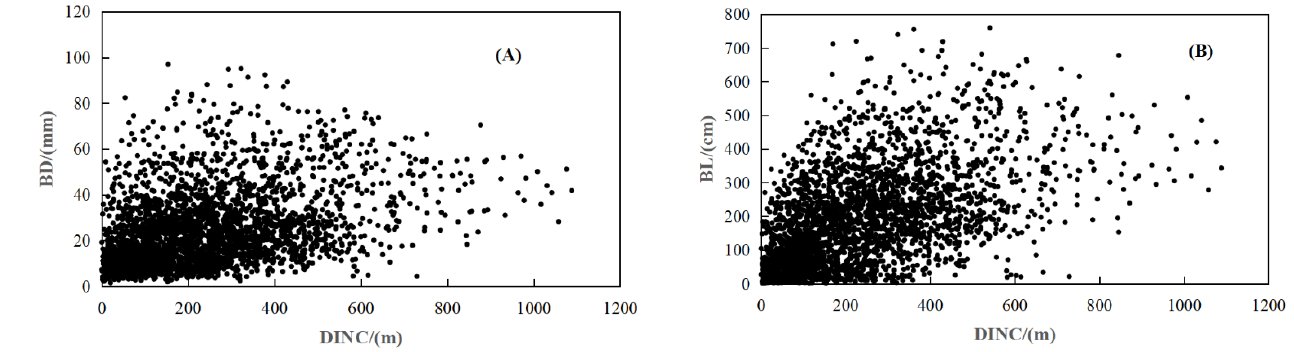
Figure 3. Distribution of branch diameter (BD, ( A )) and branch length (BL, ( B )) against the DINC from tree tip downwards the crown base within the entire crown.